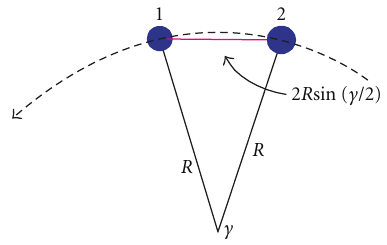
Figure 2: The diagram of angular shift, γ , for coordinates ( x 2 , y 2 ) of second-class particles relative to coordinates ( x 1 , y 1 ) of first-class particles.